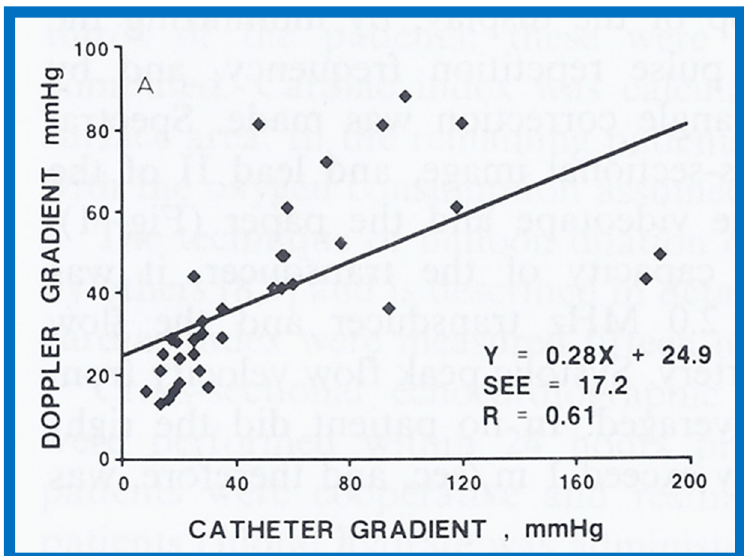
Figure 46. Scattergram demonstrating the relationship of Doppler-derived (by modified Bernoulli equation) peak instantaneous and catheterization-measured peak to peak pulmonary valve systolic pressure gradients. Note that the linear regression analysis indicated a correlation coefficient (R) of 0.61. Reproduced from Rao P.S. [14].